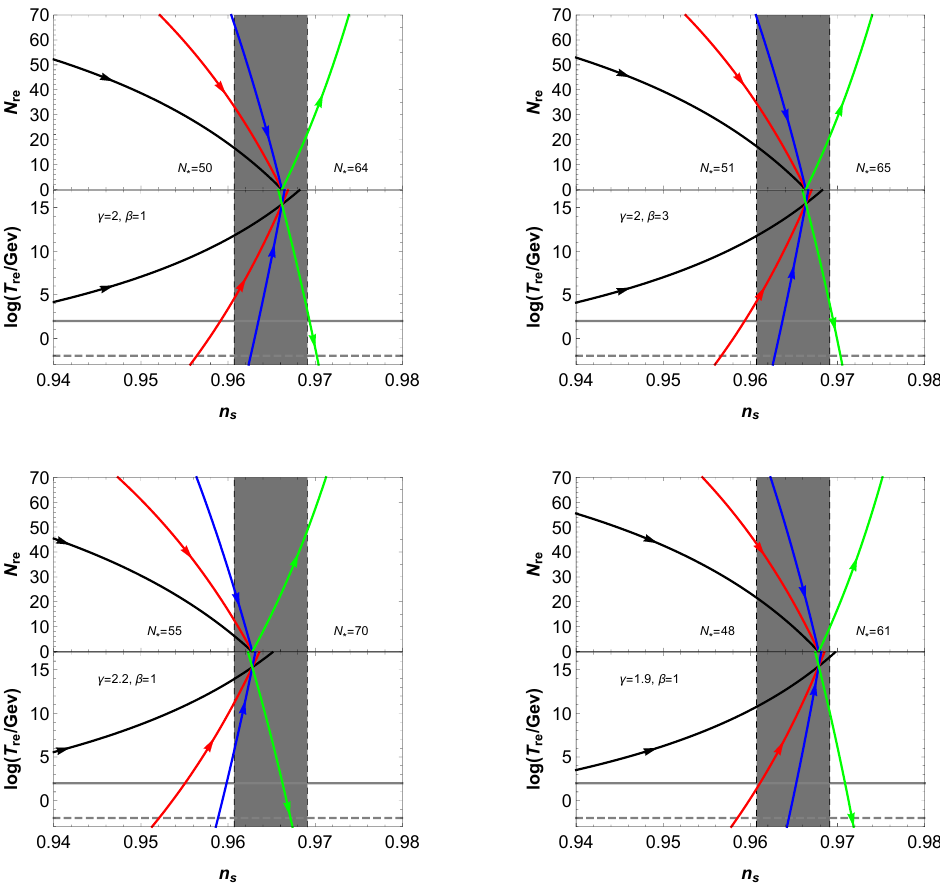
Figure 3. ( Top ) The relations between N re and n s ; and ( Bottom ) the relations between T re and n s . The corresponding values of β and γ for each model are indicated in each panel. The 1 σ Planck constraint n s = 0.9649 ± 0.0042 [5] is denoted by the gray band, and the 1 σ Planck constraint on the e -folds N is also indicated. The black, red, blue and green lines correspond to the reheating models with w re = − 1/3, 0, 1/6 and 2/3, respectively; in each line, the arrow denotes the direction of N enlargement. The horizontal gray solid and dashed lines in the bottom panels denote the electroweak scale T EW ∼ 100 GeV and the big bang nucleosynthesis scale T BBN ∼ 10 MeV,